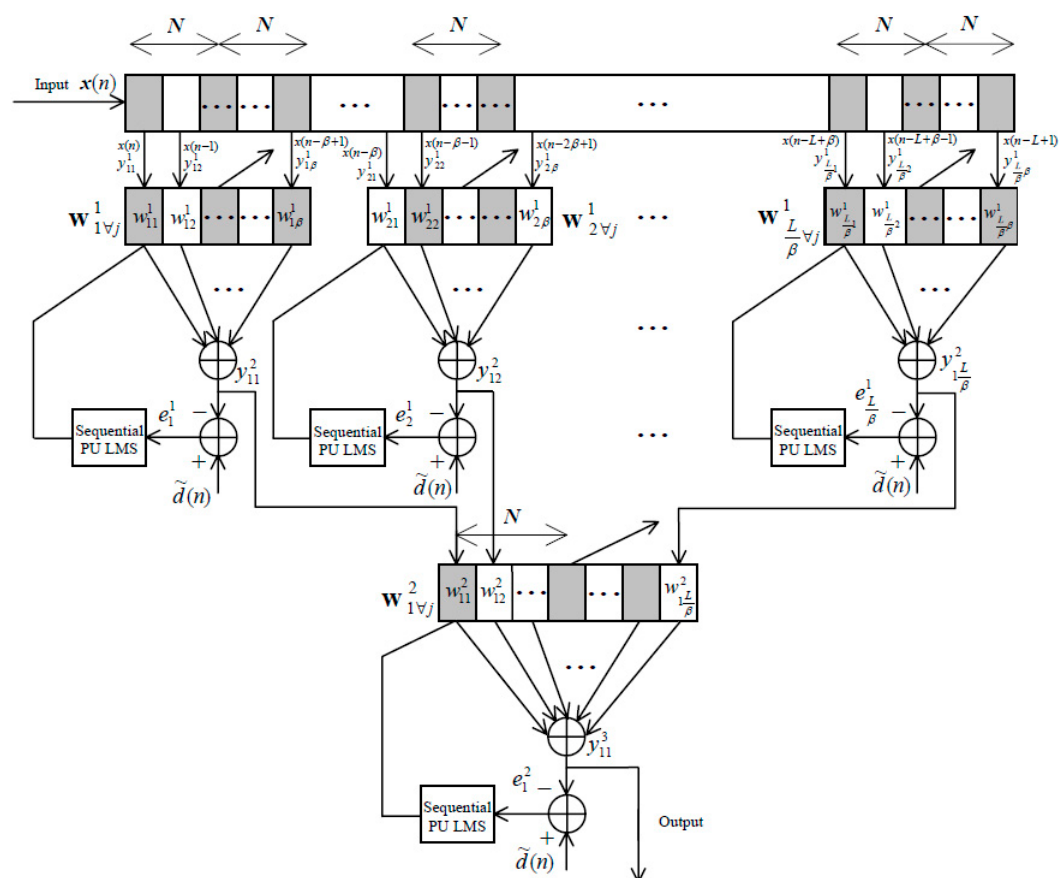
Figure 3. Two-level hierarchical filter.